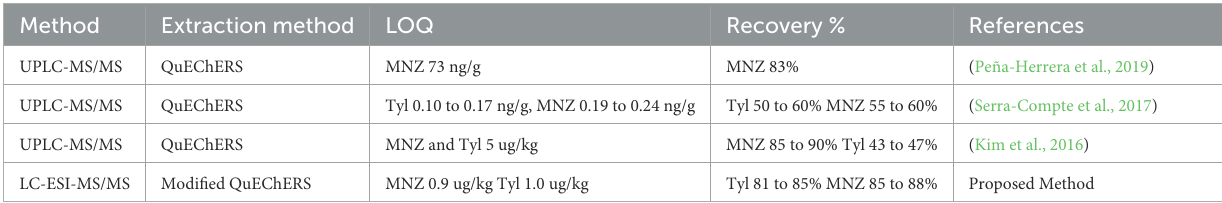
TABLE 2 A comparison of the proposed method with other reported methods for the determination of Tyl and MNZ in shrimp muscle.